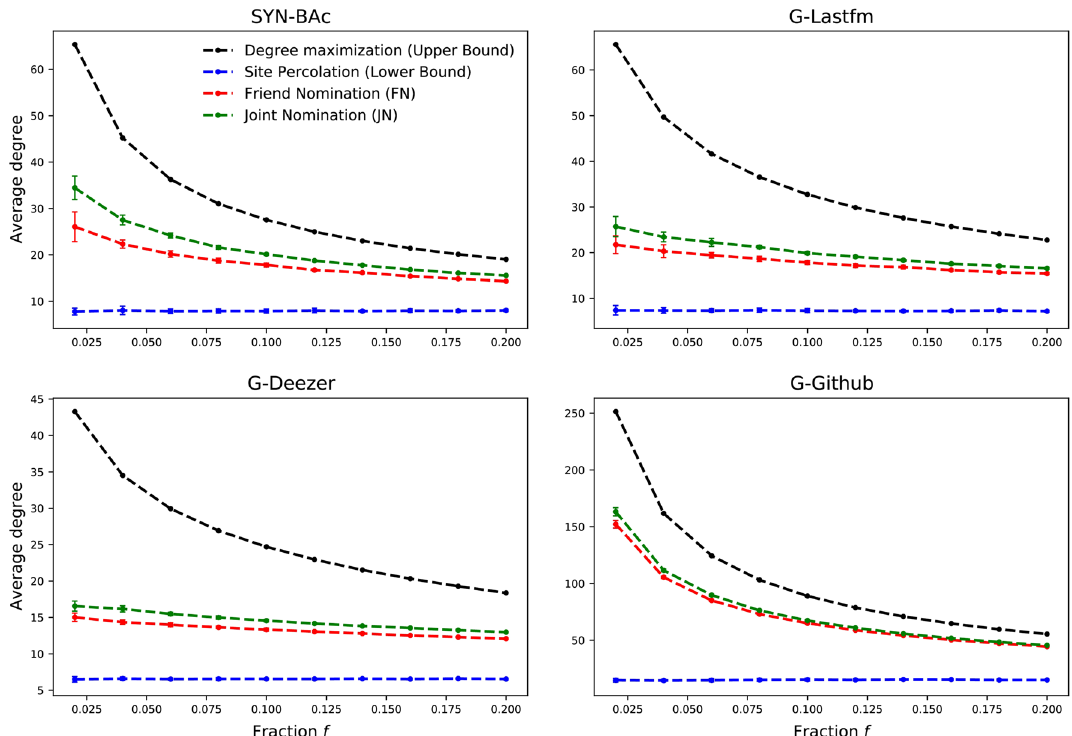
Figure 3. The average degree of the identified node set by different approaches on four datasets. The average degree of nodes identified with JN is always greater than that with FN or SP in each fraction and each dataset. With the increasing of the fraction, the gap between JN and FN shrinks, because there are not enough high degree nodes left in the network. This implies that JN can find high degree nodes more efficiently than FN. The results are averaged over 50 independent